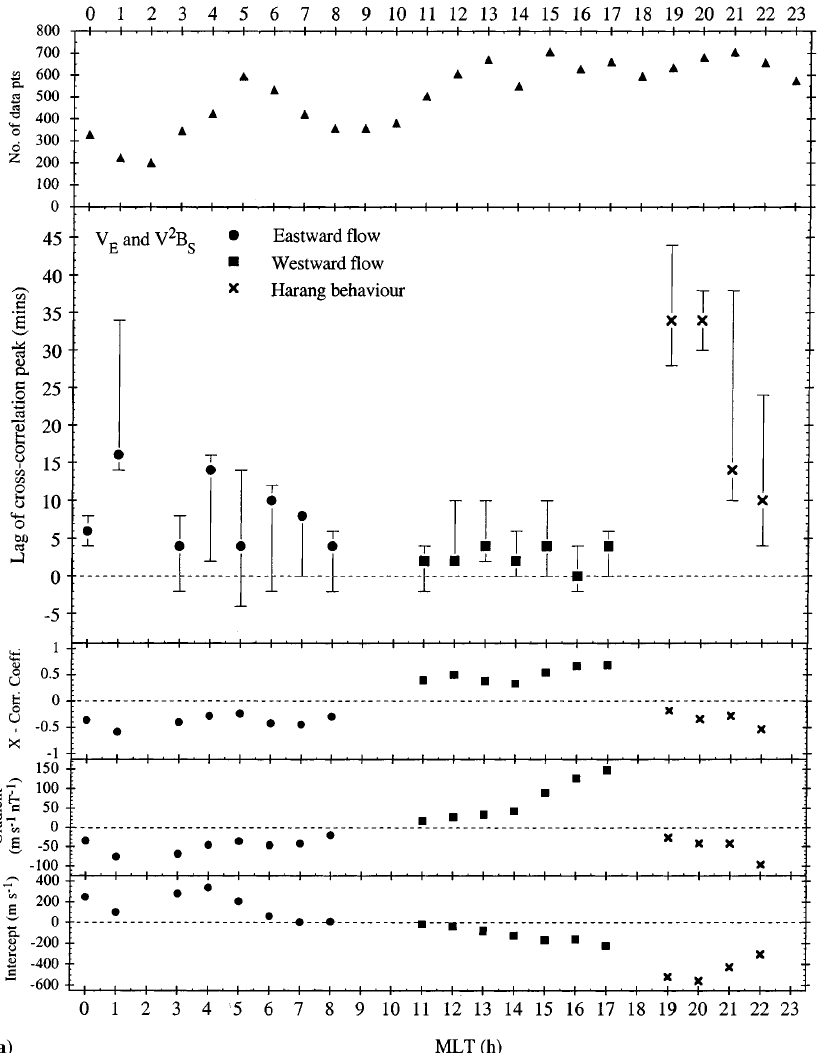
Fig. 5. a Summary of cross-correlation results for the v component squares indicate results corresponding to the dayside dusk flow cell E of ionospheric flow. The top panel shows the number of flow where the correlation coe(cid:129)cient and ‘‘gradient’’ are positive, while the measurements in each 2-h interval of MLT used in the study, ‘‘intercept’’ is negative (increasing westward flows for southward specifically at zero lag (the number of points may vary slightly with IMF). The circles indicate results corresponding to the dawn flow cell lag due to gaps in the interplanetary data record). Beneath this we where the correlation coe(cid:129)cient and ‘‘gradient’’ are negative, while show the lag of the peak value of the cross-correlation coe(cid:129)cient the ‘‘intercept’’ is positive (increasing eastward flows for southward (min). In the next panel we show the value of the cross-correlation IMF). The crosses indicate the Harang region of the nightside dusk coe(cid:129)cient at the peak. The lower two panels show the ‘‘gradient’’ and flow cell where the correlation coe(cid:129)cient, ‘‘gradient’’, and ‘‘intercept’’ ‘‘intercept’’ values of the lines least squares-fitted to the scatter plots of are all negative (flow reverses from west to east as the IMF reverses v from north versus ( V /500) 2 B , as shown in the lower panels of Fig. 4. The E s